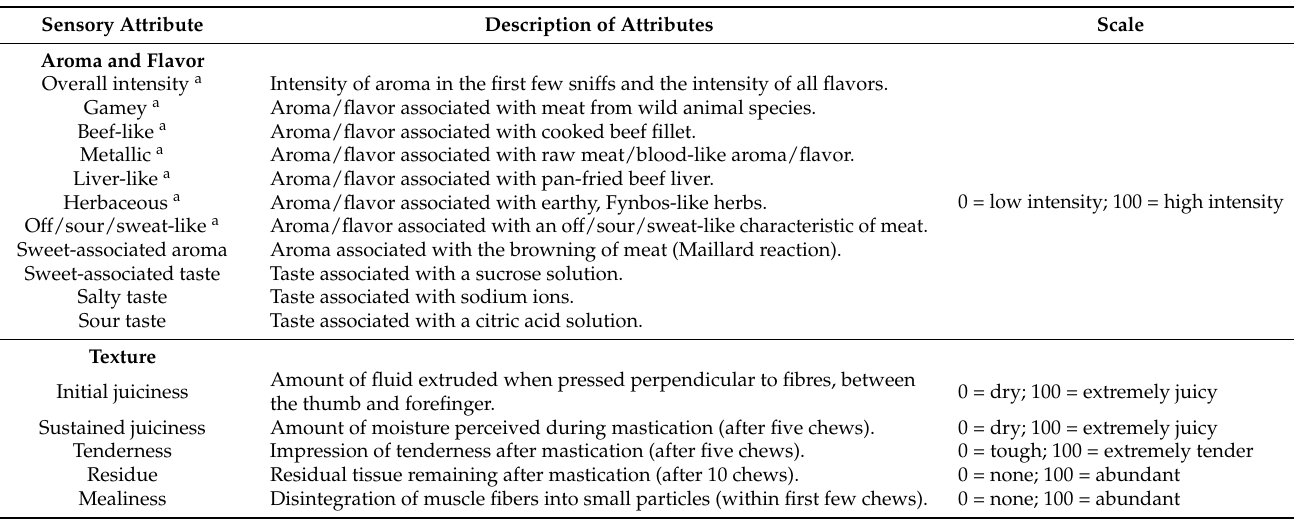
Table 3. Description and scale of the sensory attributes (aroma, flavor, and texture) decided upon by the trained sensory panel for the descriptive sensory analysis (DSA) of impala meat ( longissimus thoracis et lumborum ) from three different production systems. Sensory Attribute Description of Attributes